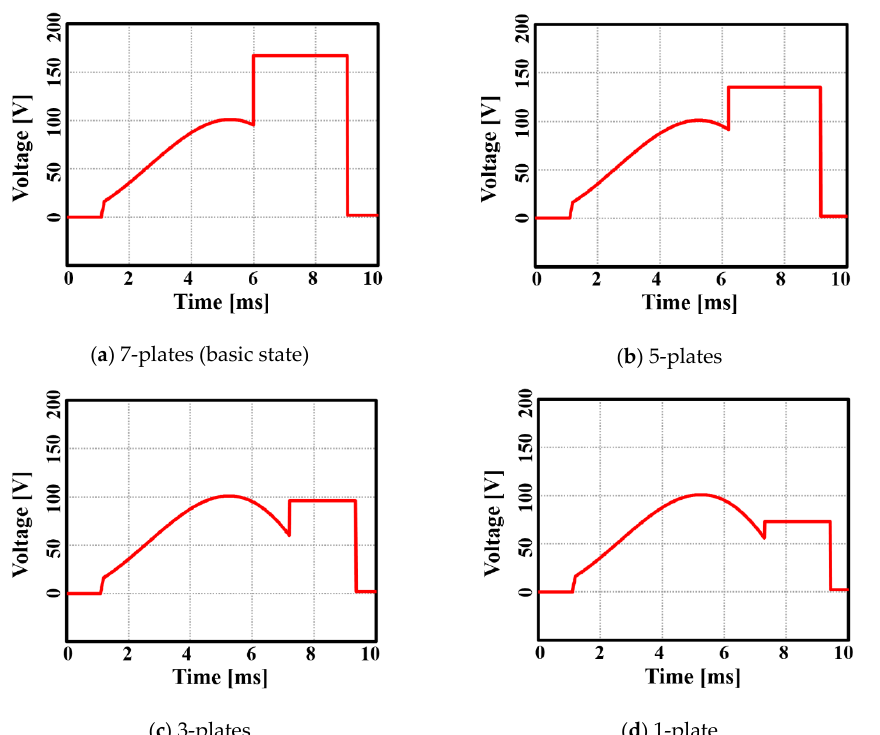
Figure 13. Simulation results for the circuit model.